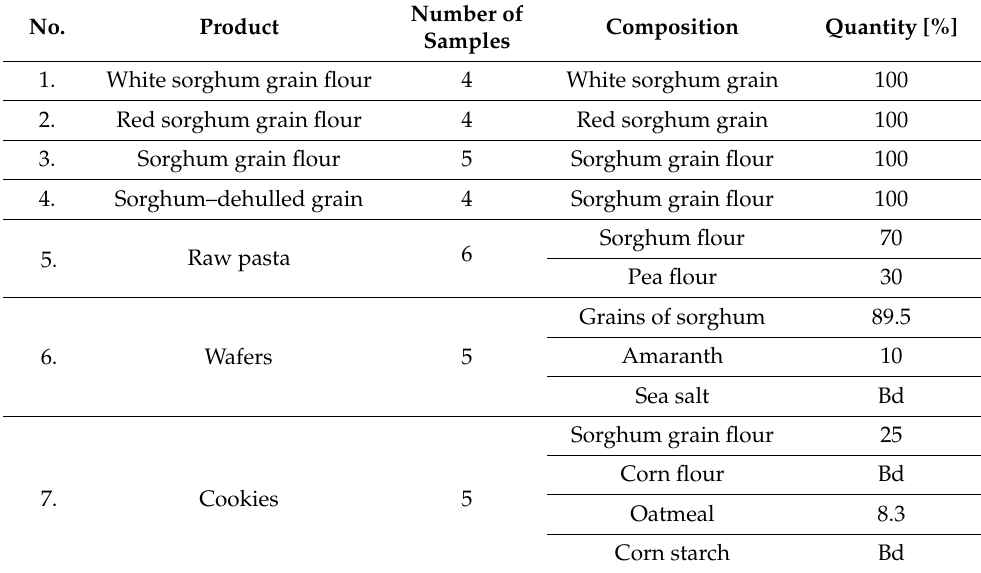
Table 1. Characteristics of the tested